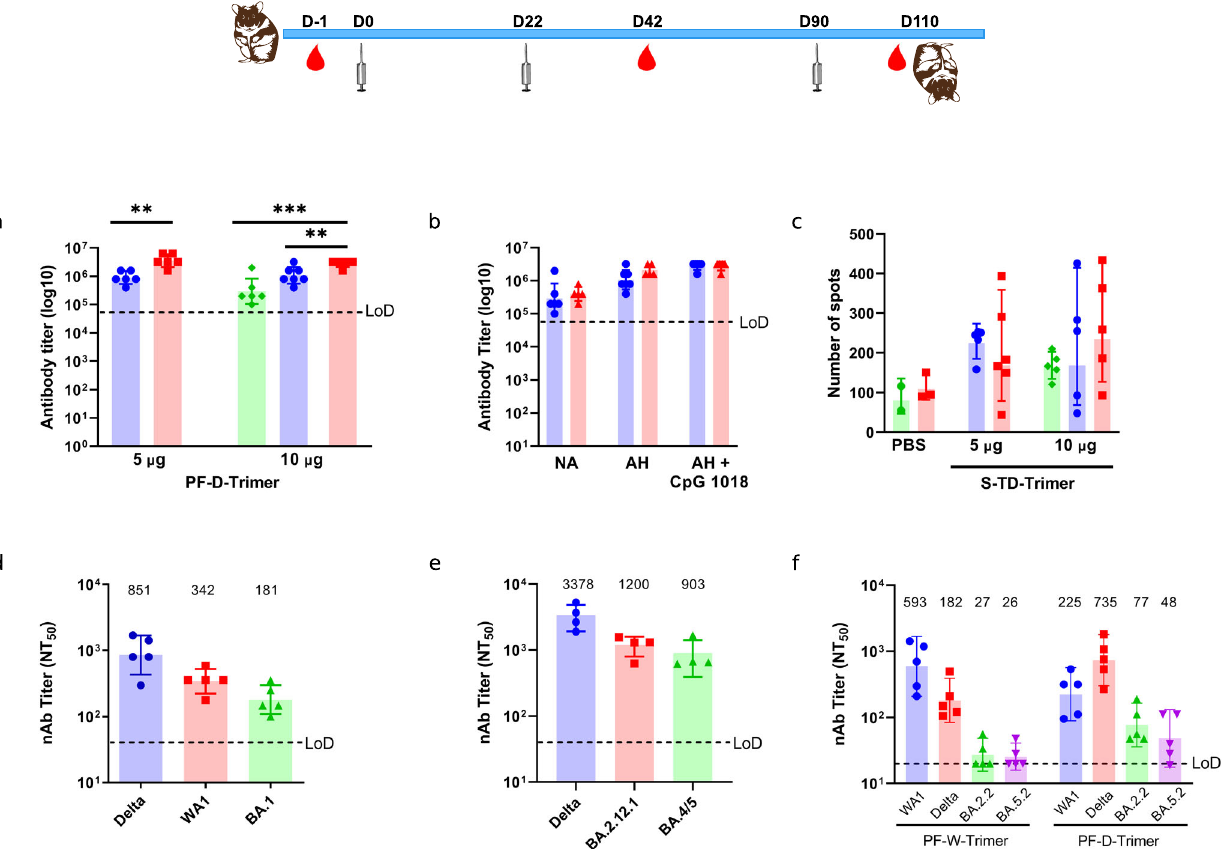
Fig. 4 Immunogenicity of the PF-Trimers in Syrian golden hamsters. Syrian golden hamsters were immunized with two different doses of PF-Trimers formulated or not with alum plus CpG 1018, as indicated in the top panel and as described in Methods. Sera were collected and the immune responses were analyzed twenty days after the second and third injections (Day 42 and Day 110). a PF-D-Trimer binding antibody ELISA titers at Day 42. ♦ Not Adjuvanted, ● Alum, ■ Alum plus CpG 1018. b Comparison of different PF-D-Trimer (10 μ g) formulations binding antibody ELISA titers at Day 42 and Day 110. NA, not adjuvanted; AH, alum; AH + CpG 1018, alum plus CpG 1018. ● Second immunization, ▲ Third Immunization. c Detection of IFN- γ + splenocytes by ELISpot after stimulation by PF-D-Trimer. ♦ Not Adjuvanted, ● Aluminium Hydroxide, ■ Alum plus CpG 1018. d Sera neutralization activities against WA1, Delta, and Omicron BA.1 from PF-D-Trimer immunized animals using a live virus neutralization assay. e Sera neutralization activities against SARS-CoV-2 Delta, BA.2.12.1 and BA.4/5 pseudotyped viruses from PF-D-Trimer immunized animals. f Comparative sera neutralization studies from PF-W-Trimer, and PF-D-Trimer immunized animals toward SARS-CoV-2 WA1, Delta, BA.2.2 and BA.5.2, using a live virus neutralization test. The titers below the limit of detection (LOD) were set to 20. ● WA1, ■ Delta, ▲ BA.2.2, ▼ BA.5.2. Points represent individual animal; bars indicate geometric mean titers (GMT) responses (with geometric standard deviation) for antibody assays and geometric mean counts (GMC) responses (with geometric standard deviation) for ELISpot. ** p ≤ 0.01, *** p ≤ 0.001. Dotted lines indicate the limits of detection, LOD; a 5 × 10 4 . b 5 × 10 4 . c 5 × 10 4 . d 30. e 30. f 20. Two-tailed t-tests were used to compare the means of each two groups. Ordinary one-way ANOVA with Dunnett ’ s multiple comparison was used to analyze the differences among